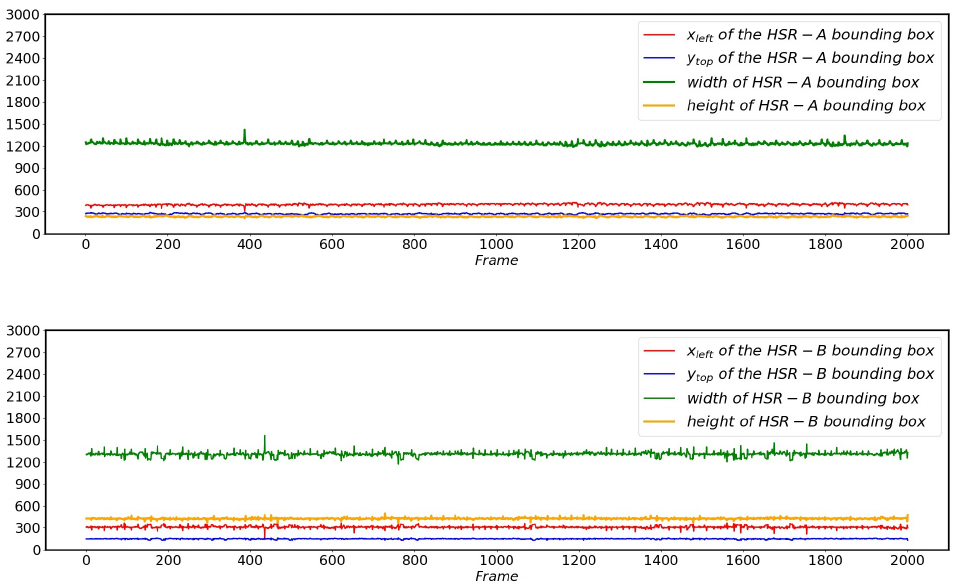
Figure 7. Changes of the four parameters of the bounding box when YOLO V4 is positioned normally without external